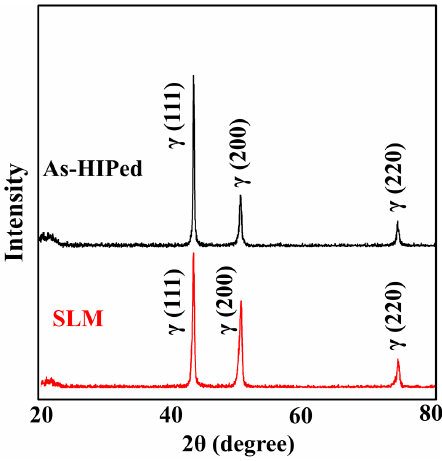
Figure 4. X-ray diffraction (XRD) patterns of as-HIPed and as-built SLM samples.